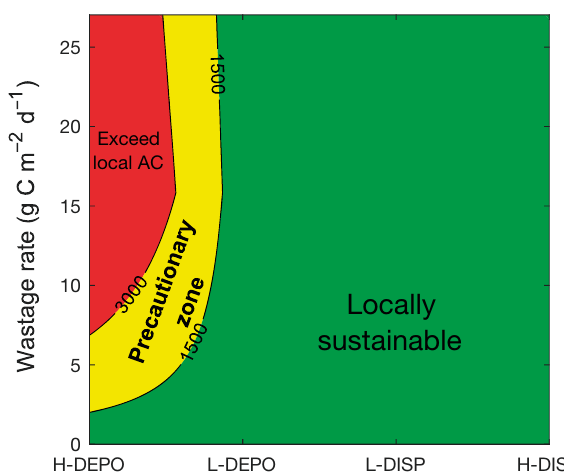
Fig. 7. Traffic-light model predicting environmental sustain- ability of aquaculture operations based on hydrodynamic conditions, the wastage rate at the base of the fish cage, and the predicted benthic response to organic enrichment. Envi- ronmental performance of aquaculture operations is consid- ered successful if assimilative capacity (AC-H 2 S) is not exceeded throughout the fish farm cycle. The precautionary area (yellow) that separates sustainable (green) from unsus- tainable (red) aquaculture is defined based on the maximum sulfide concentration predicted in surface sediments (upper 2 cm) throughout the fish farm cycle. The precautionary lim- its are 1500 to 3000 µM total S 2− . The traffic-light model was developed considering twice-per-day feeding (20 min each), constant production of feces, a constant culture density of 8 kg m −3 , and a wastage rate between 0 (ambient deposition) and 27.4 g C org m −2 d −1 (0 to 8% feed